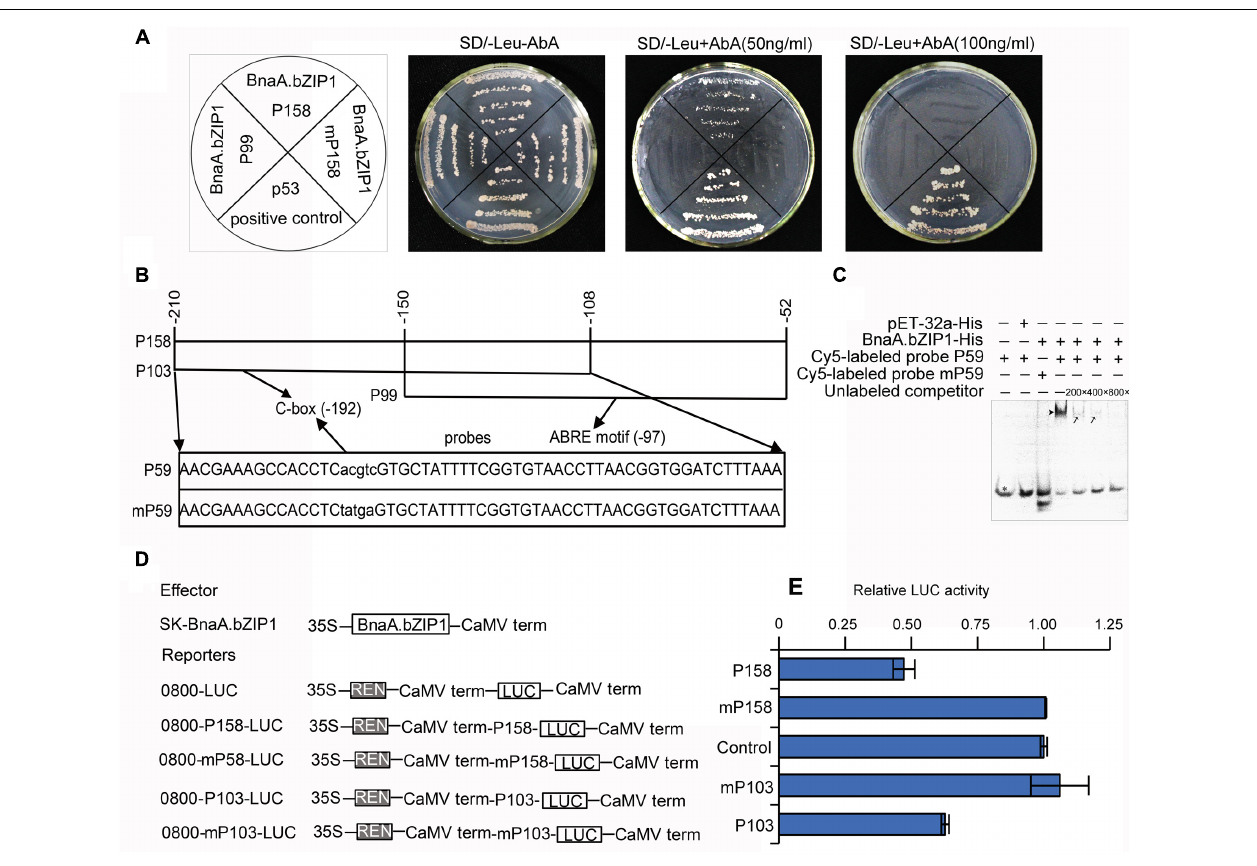
FIGURE 5 | BnaA.bZIP1 binds to the p158 promoter region and acts as a transcriptional repressor. (A) Growth of the co-transformed yeast cells on SD/-Leu plates without or with AbA (50 or 100 ng ml − 1 ). (B) Diagram of the p158 region. The p158 region was divided into p103 and p99 regions, with a 43-bp overlap, containing putative C-box and ABRE motifs, respectively. The p59 and mp59 probes containing the C-box or mutated C-box were used for EMSA. The core sequence (CACGTC) of the C-box was changed to Ctatga (underlined). (C) Binding of BnaA.bZIP1 to the C-box of p158 region in EMSA. The BnaA.bZIP1-His protein was incubated with the Cy5-labeled probe containing the C-box or mutated C-box; the pET-32a-His protein was used as a negative control; the unlabeled promoter fragment was used as a competitor in the assay. − , absence; + , presence; black triangle indicates the shifted band; black arrows indicate reduced intensity of the shifted bands; a black star indicates the free probes. (D) Schematic representation of the constructs used for the dual luciferase reporter (DLR) assay in Arabidopsis protoplasts. BnaA.bZIP1 driven by the CaMV35S promoter was used as an effector. For each reporter construct, the firefly LUC gene was driven by the p158, p103, mutated p158 (mp158), and mutated p103 (mp103) promoter, respectively. (E) The promoter activity was indicated by a ratio of LUC to REN as described in Figure 4 ( n = 3). The value of the control was set to 1. Error bars represent the SE of three biological